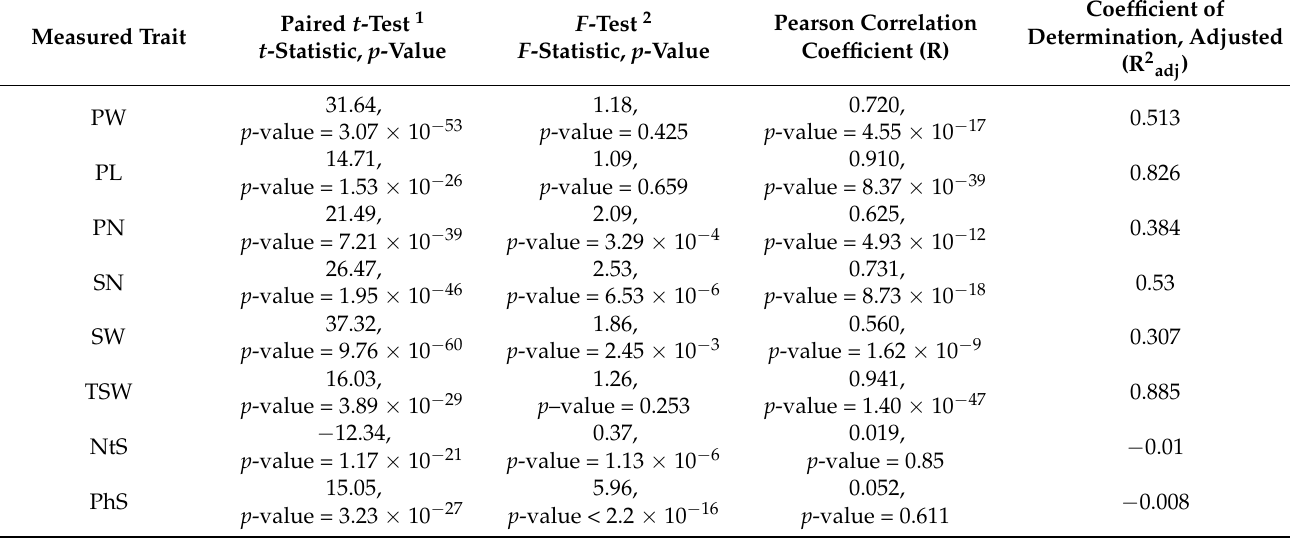
Table 3. Comparisons between the traits values in Rh and Rh + AM